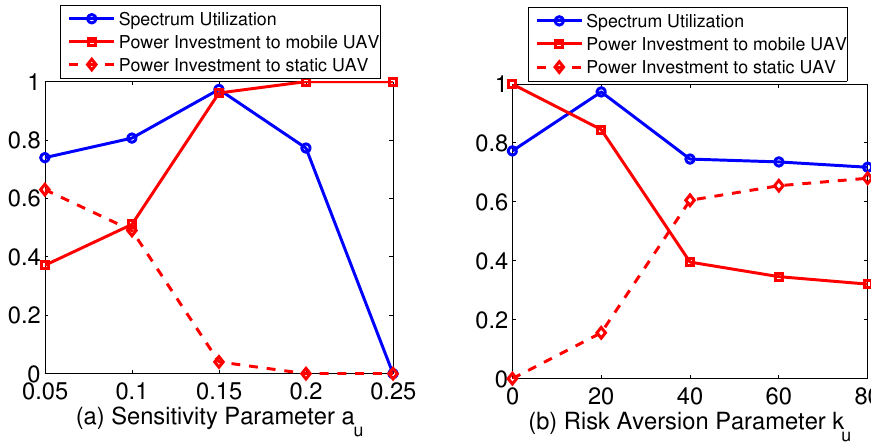
Figure 3. Average spectrum utilization and power investment for varying: ( a ) sensitivity (i.e., parameter a u ); and ( b ) risk aversion (i.e., parameter k u